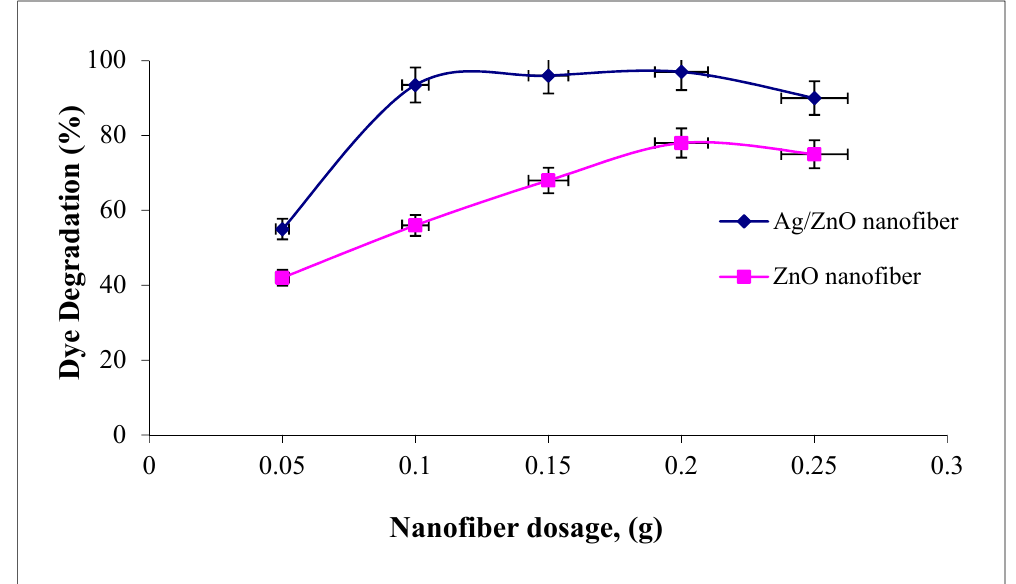
Figure 8. Effect of adsorbent dosage on the MG dye photocatalytic degradation process using ZnO polymeric nanofibers after and before silver immobilization (initial dye concentration = 20 ppm, pH = 7, contact time = 60 min at room temperature).